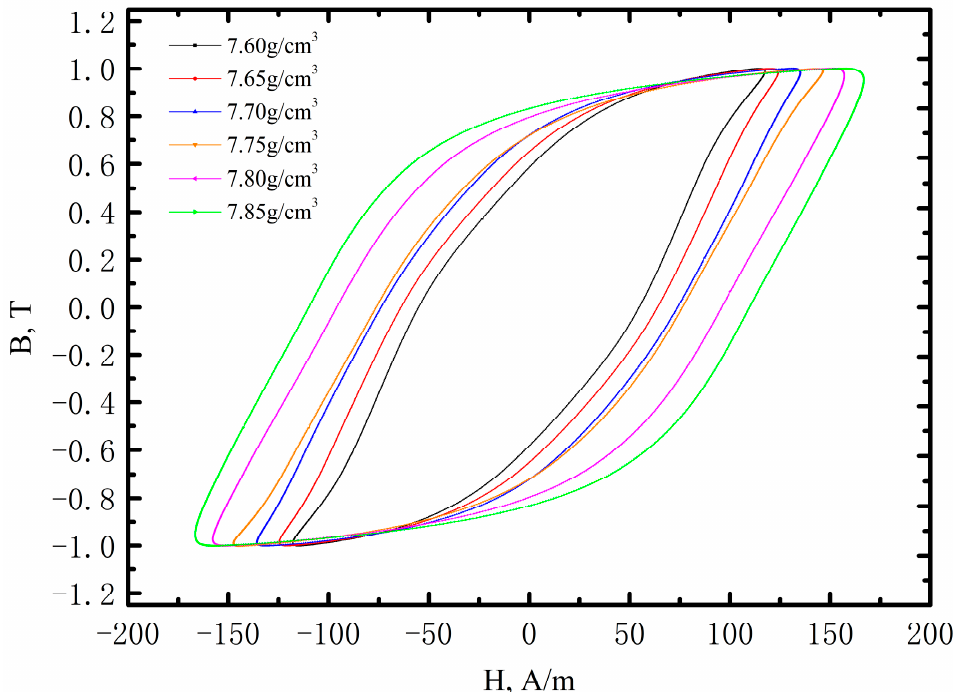
Figure 9. Hysteresis curves at the magnetic induction intensity of 1.0 T for the samples processed by laser cu tt ing.